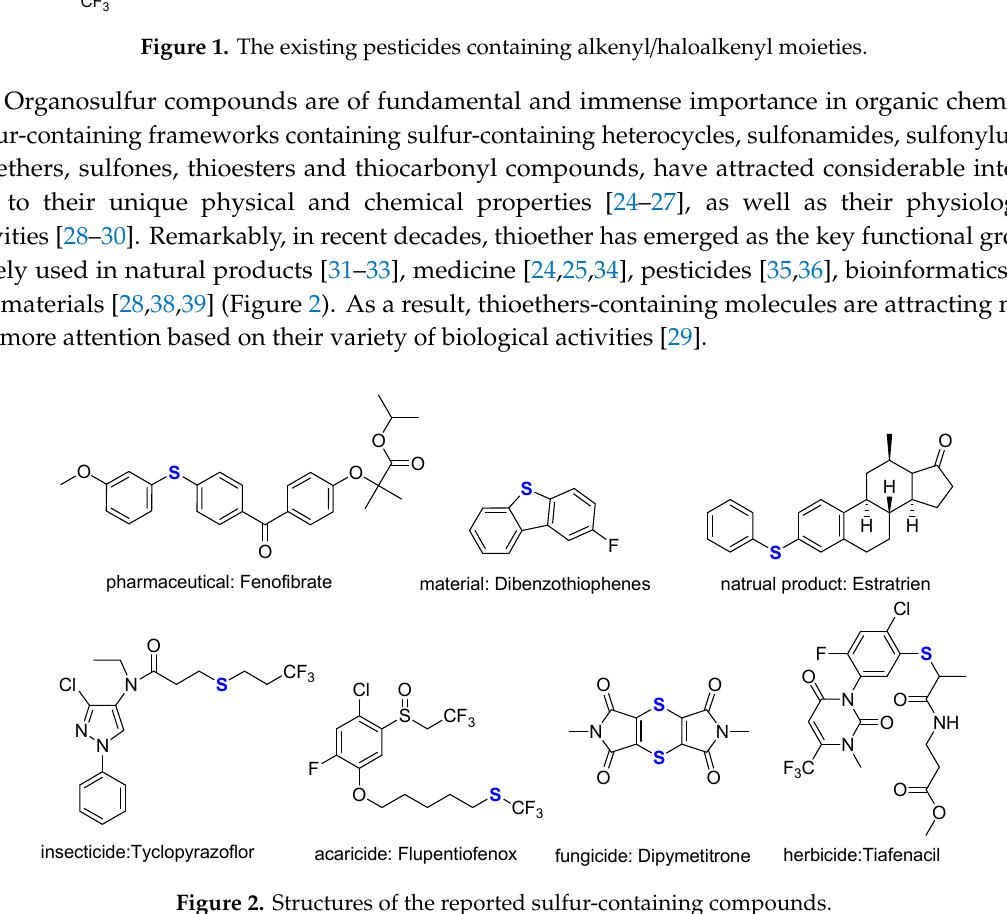
Figure 2. Structures of the reported sulfur-containing compounds.